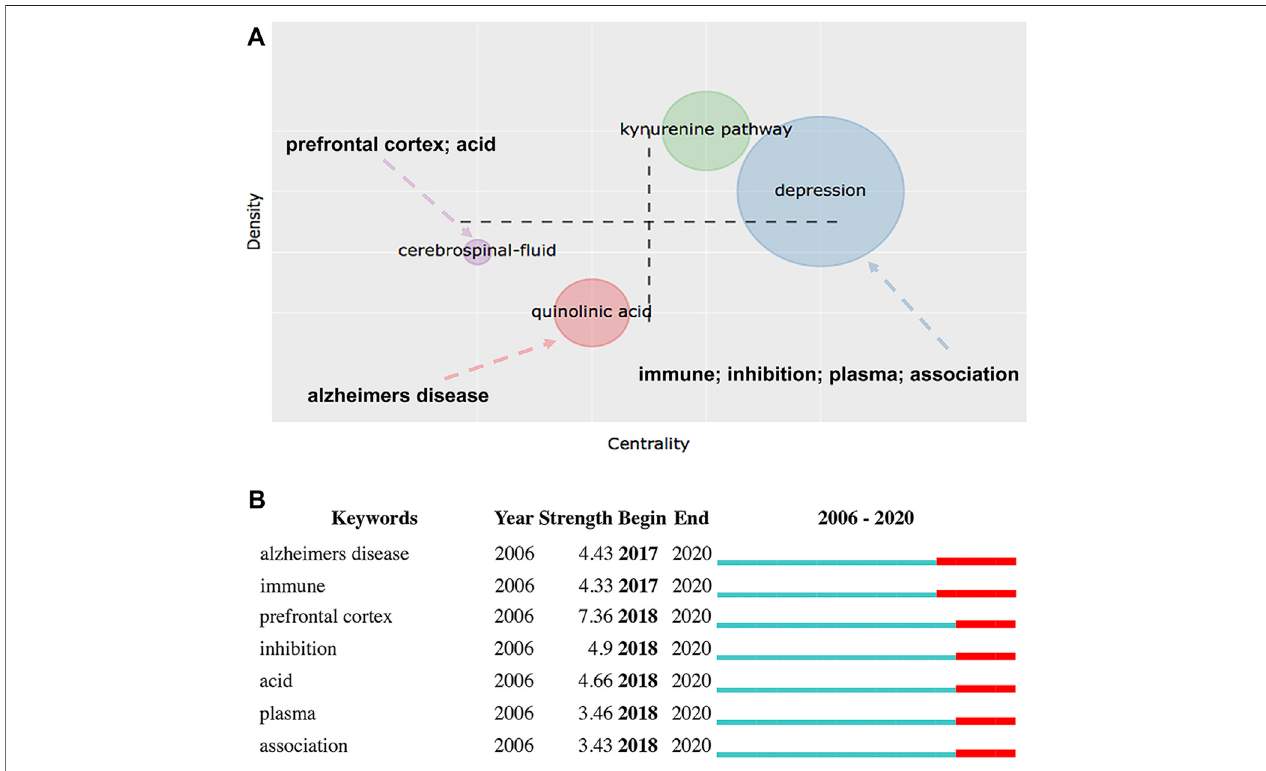
FIGURE11| | (A) Thematicmapof “ KeywordsPlus ” createdbythebiblioshinyapp (B) Keywordswiththestrongestcurrentlyongoingcitationbursts.Theredbars indicate the duration of the burst and re fl ect keywords cited frequently; in contrast, the green bars indicate keywords cited infrequently. These keywords identi fi ed by Citespace were found within the clusters labeled “ depression, ” “ quinolinic acid, ” and “ cerebrospinal- fl uid ” in the thematic map.